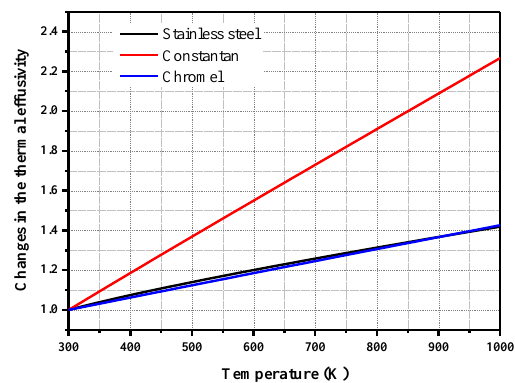
Figure 9. Changes in the thermal effusivity versus the temperature.